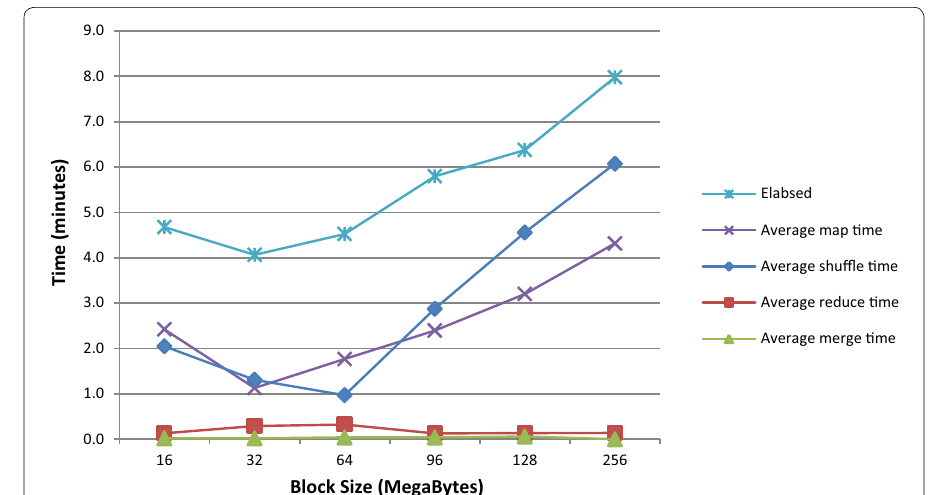
Fig. 23 Clustering 1.9 GB raster image with a 50 nodes Hadoop